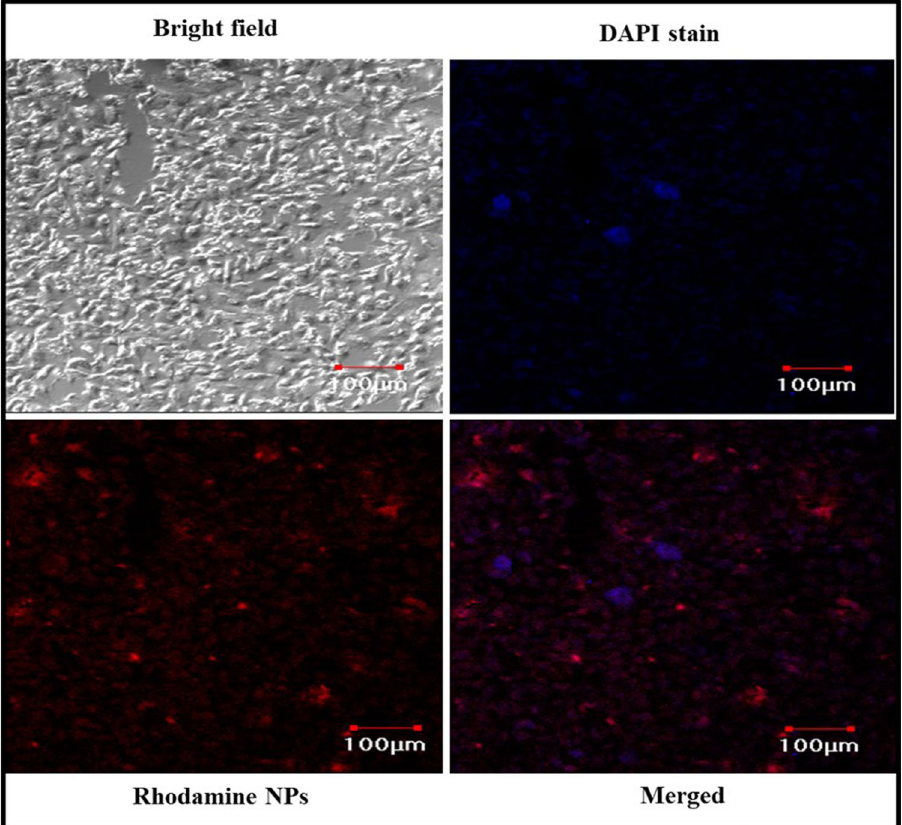
Figure 3. Cellular uptake study of nanoparticles in A549 cell lines imaged using confocal laser scanning microscope